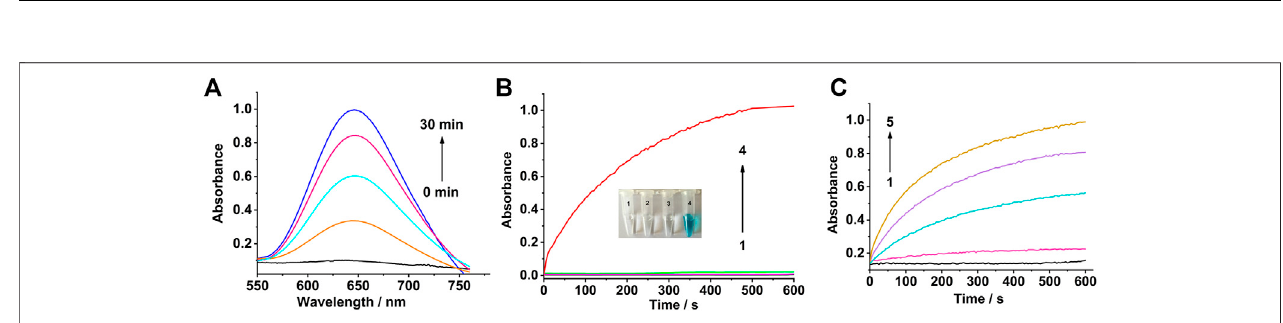
FIGURE 2 | Peroxidase-like activity of the Co 3 O 4 nanosheets. (A) UV – Vis spectra of the mixed solution ofTMB, H 2 O 2 , and Co 3 O 4 nanosheets with different times. (B) Time-dependentabsorbancechangesat650 nmofTMBsolutionsindifferentconditions:(1)Co 3 O 4 + H 2 O 2 ,(2)Co 3 O 4 +TMB,(3)H 2 O 2 + TMB,and(4)Co 3 O 4 + TMB + H 2 O 2 . (C) Time-dependent absorbance changes at 650 nm inthe absence(black) or presence ofdifferent concentrations ofthe Co 3 O 4 nanosheets: (1) – (5) are0, 0.5, 5, 10, and 20 μ g ml − 1 ,